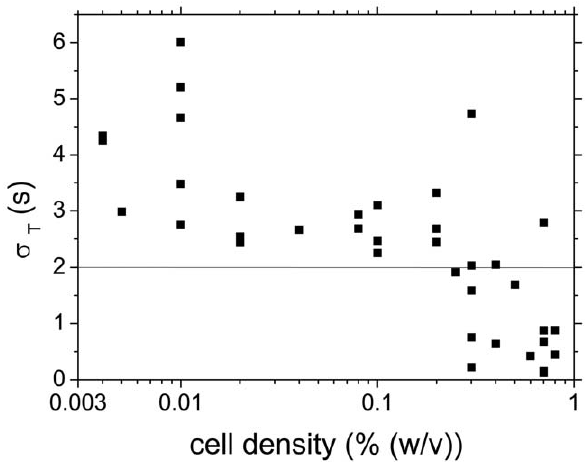
Figure 6. Width of the distribution of oscillation periods in individual experiments, as measured by the standard devia- tion s T of the Gaussian fit to the histogram of oscillation periods. For cell densities r below r crit =0.3%, s T w 2 s pointing at decoherence in oscillation periods. The line at s T indicates the sampling rate (2 s). All points below s T =2 s originate from coherent